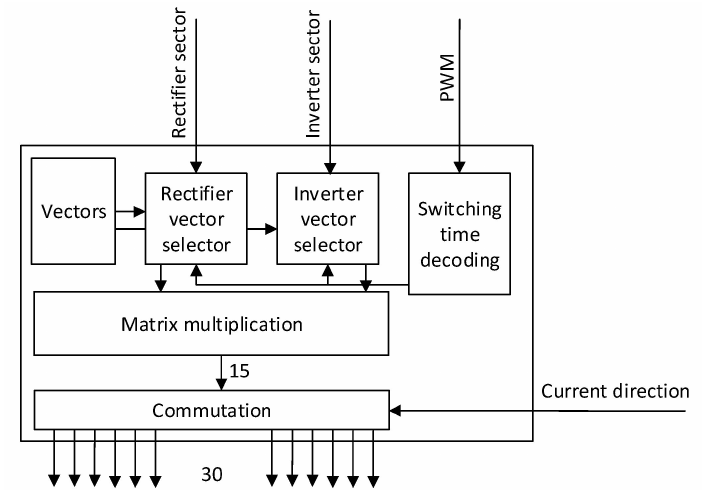
Figure 7. Block diagram of the control